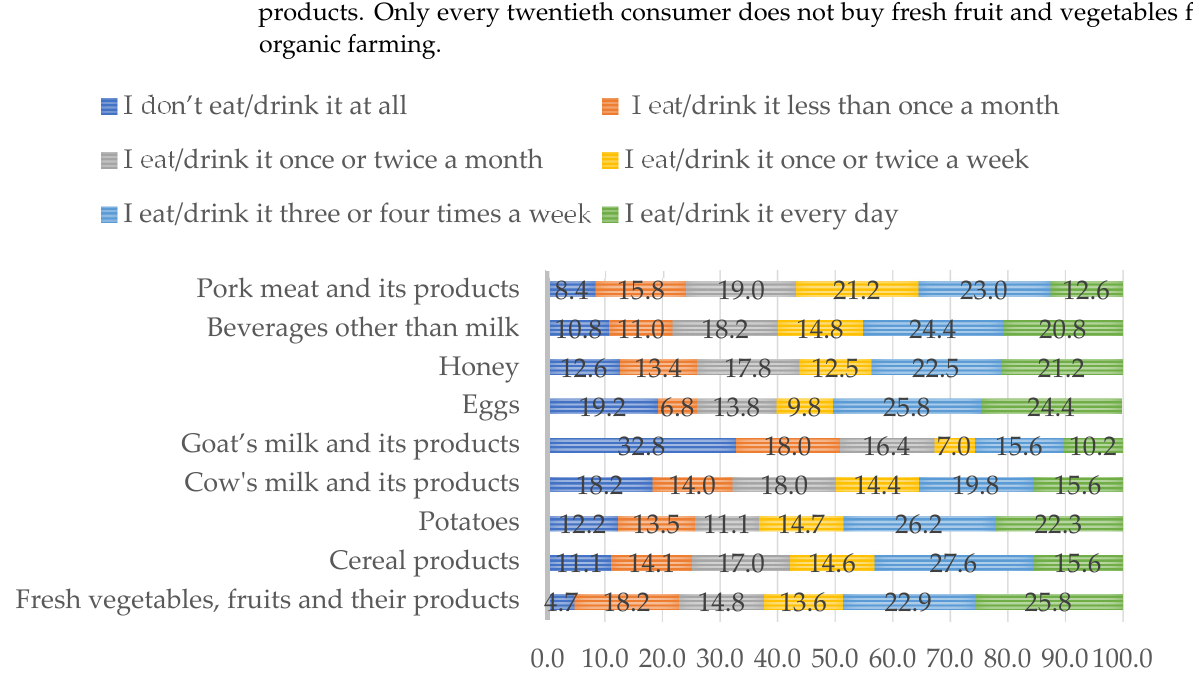
Figure 2. The frequency of various organic products by Polish consumers in the research sample. Note: The data is given as a percentage. Source: Our own analysis based on the study materials.